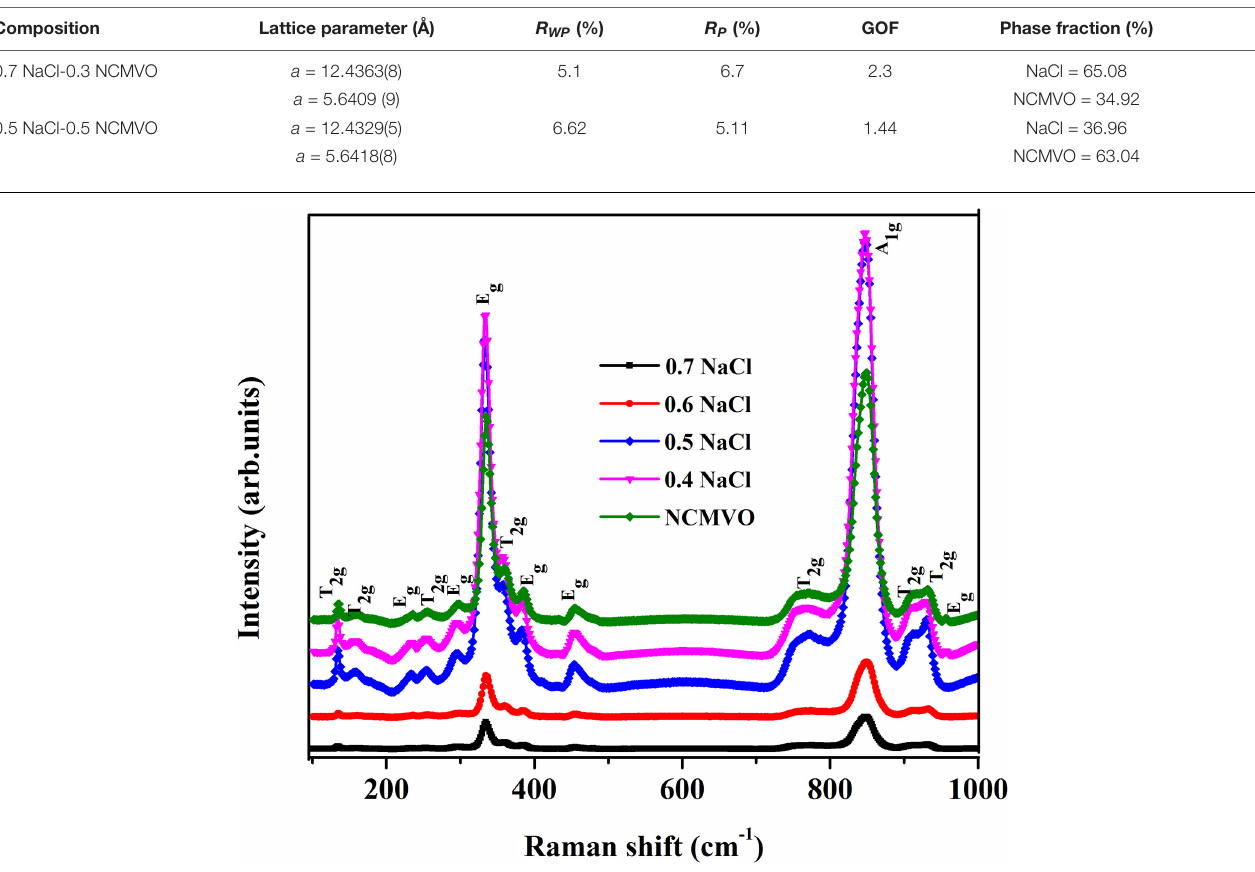
TABLE 1 | Refined Structural Parameters of NCMVO- NaCl Composite Ceramic. Composition